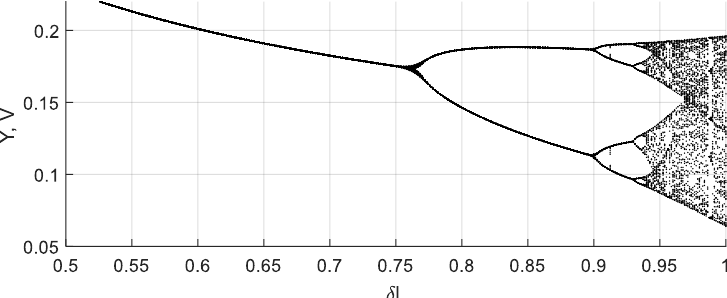
Figure 11. Bifurcation diagram of the chaotic circuit based on the Sprott Case N chaotic oscillator. When the inductance L changes from 0.5 to 1 of its nominal value, the system regime changes from periodic to chaotic oscillations through period doubling.